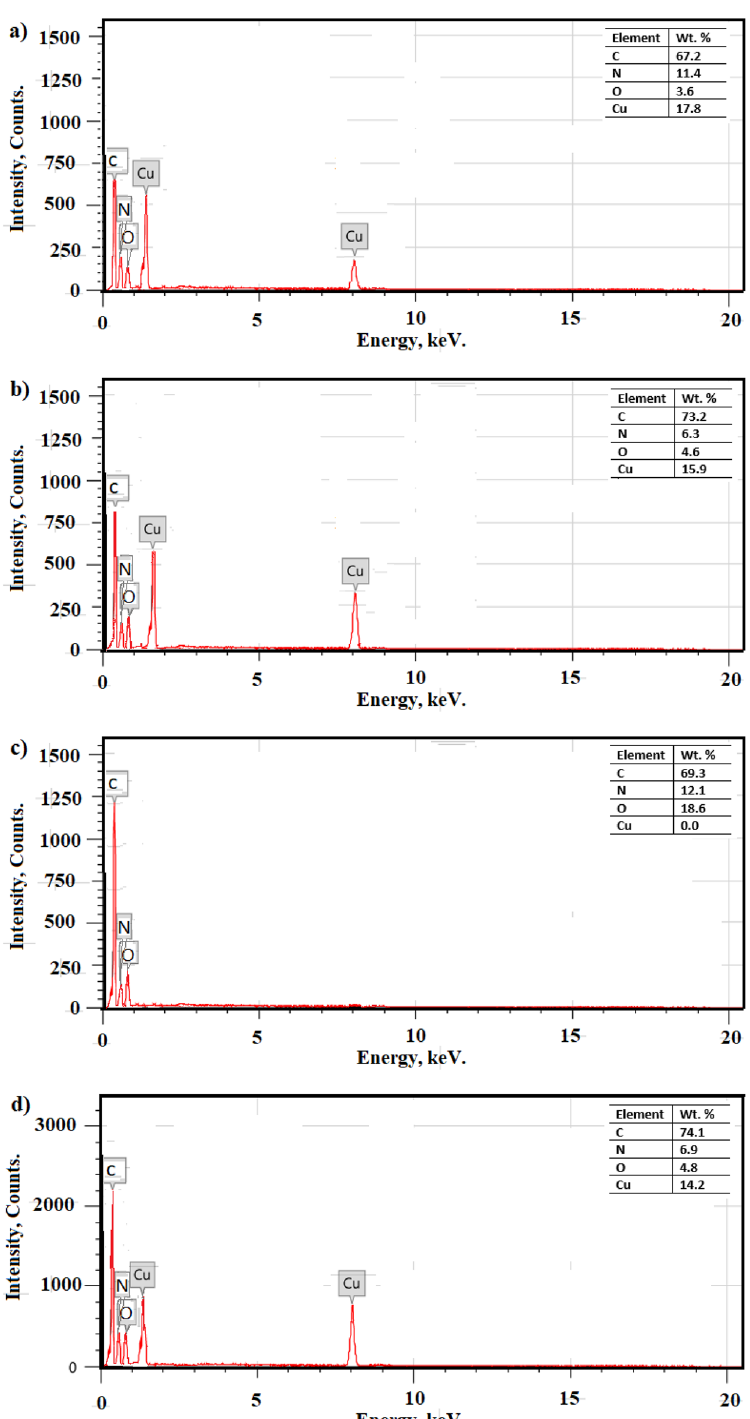
Figure 5. EDX micrographs of the ( a ) Cu-Asp MOF, ( b ) Cu-Asp MOF@SA, ( c ) pristine textile fabric, and ( d ) modified textile